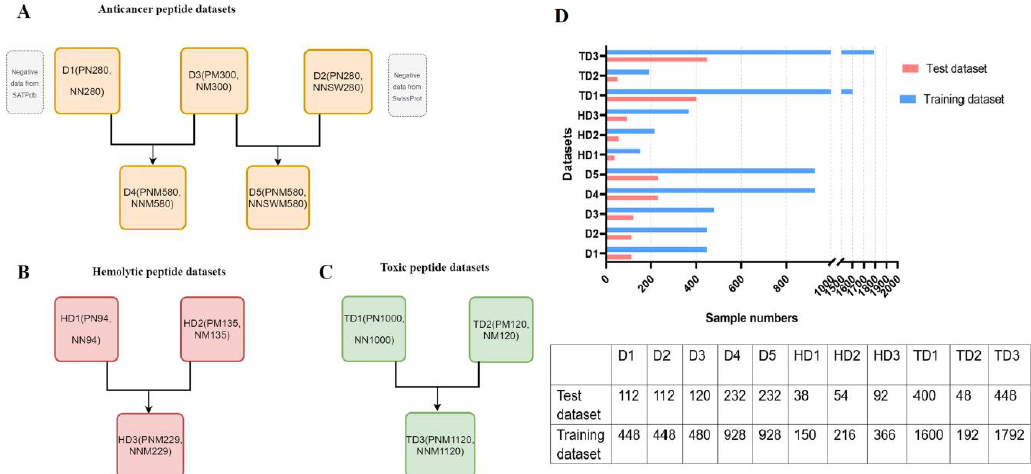
Figure 2. Composition of multiple datasets. ( A ) Number of positive and negative samples in five datasets of anticancer peptides. PN, NN, NNSW, PM and NM indicate positive natural peptides, negative natural peptides, negative natural peptides derived from SwissProt, positive chemically modified peptides and negative chemically modified peptides, respectively. PNM represents a positive dataset of mixed natural peptides and chemically modified peptides. NNM implies a negative dataset of mixed natural peptides and chemically modified peptides. ( B ) The number distribution of positive and negative samples of three hemolytic peptides datasets. ( C ) The number distribution of positive and negative samples in three toxic peptide datasets. ( D ) Data splitting of all datasets. Blue indicates training set; pink indicates test set.